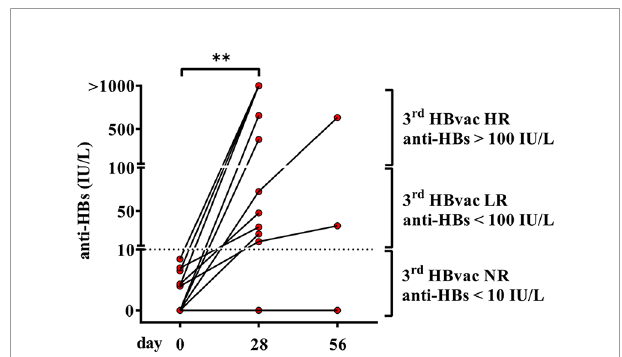
FIGURE 1 | Anti-HBs levels of second-generation hepatitis B vaccine non- responders before and after vaccination with third-generation hepatitis B vaccine Sci-B-Vac ™ . Depicted are anti-HBs levels (IU/L) of second- generation hepatitis B vaccine non-responders (2 nd HBvac NR, n = 11) before (day 0), after primary (day 28), and second (day 56, n = 3) Sci-B-Vac ™ vaccination. The dashed line indicates the threshold for protective anti-HBs levels (> 10 IU/L). The interconnected lines link the respective data points of each subject at each time point. Statistics are based on paired Wilcoxon signed rank tests. ** p <